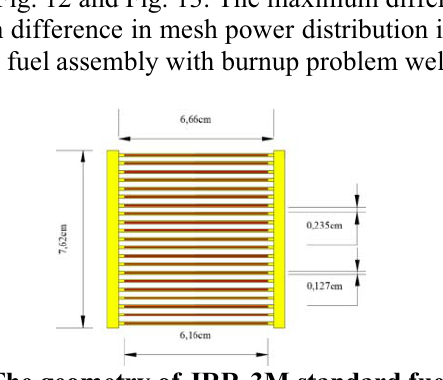
Figure 10. The geometry of JRR-3M standard fuel assembly